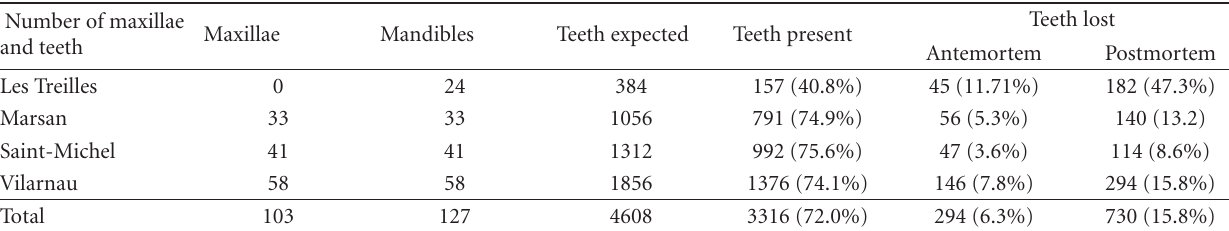
Table 1: State of dental